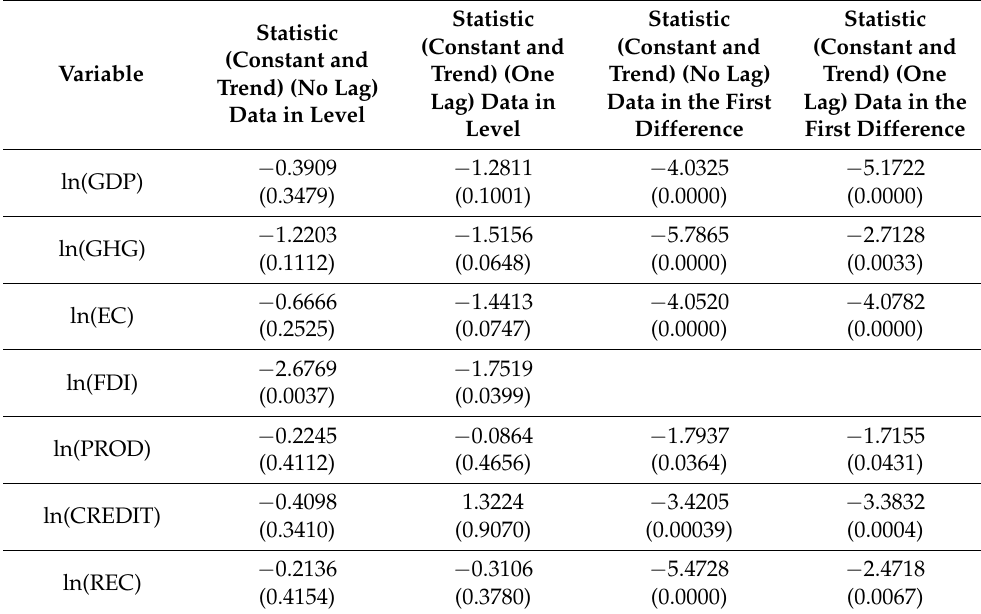
Table 6. The results of Pedroni and Westerlund tests.